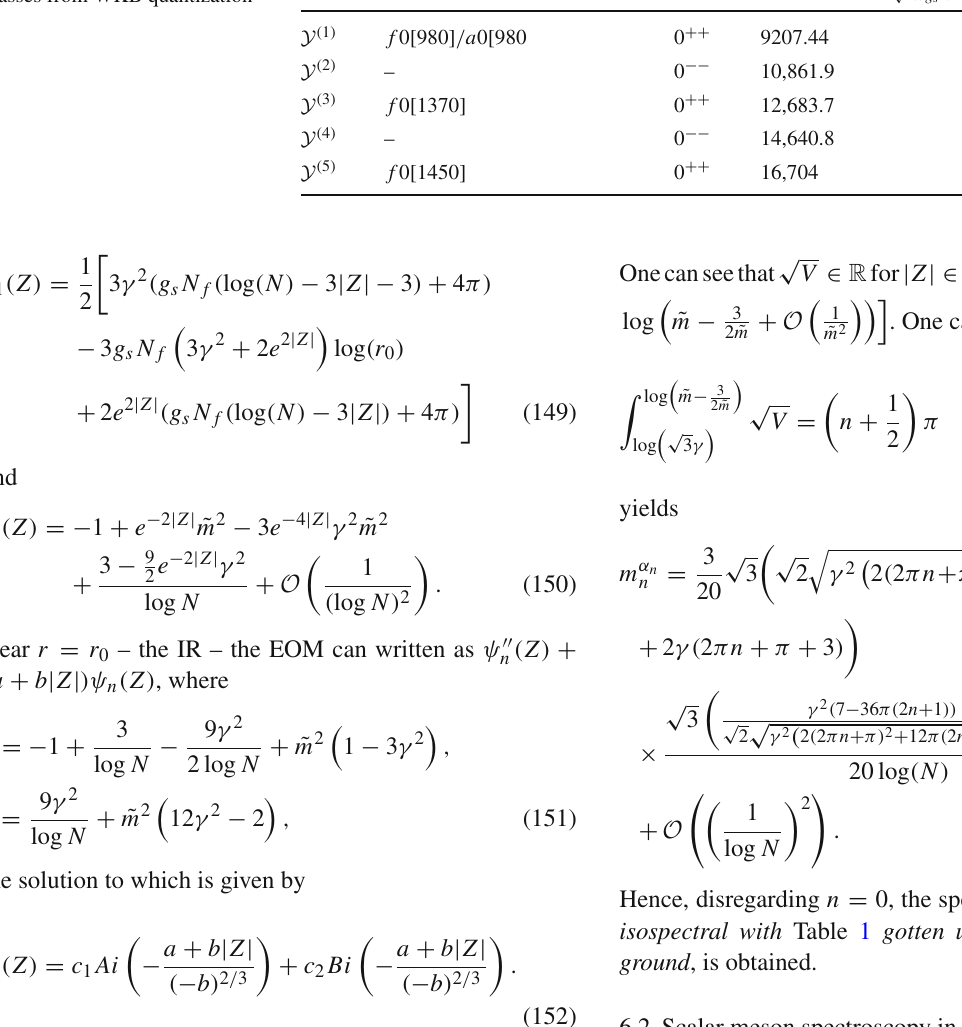
Table 4 (Pseudo-)scalar meson masses from WKB